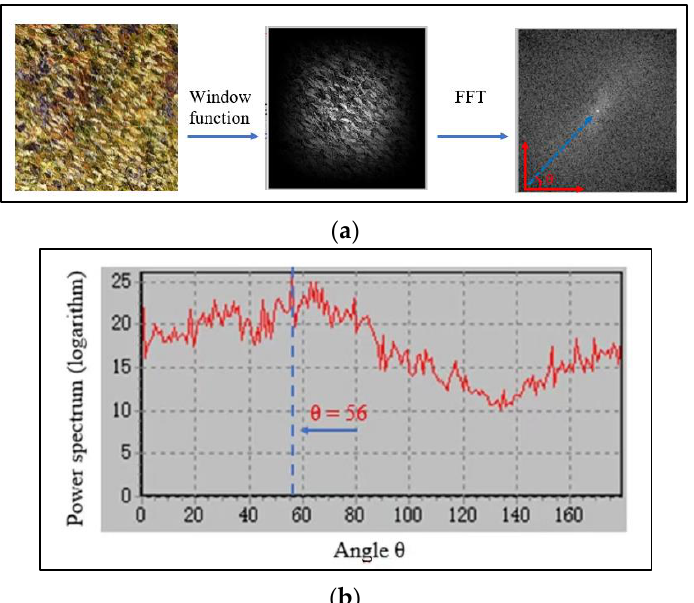
Figure 9. ( a ) Calculate the average value of the power spectrum of each angle, ( b ) Monet stroke direction information.